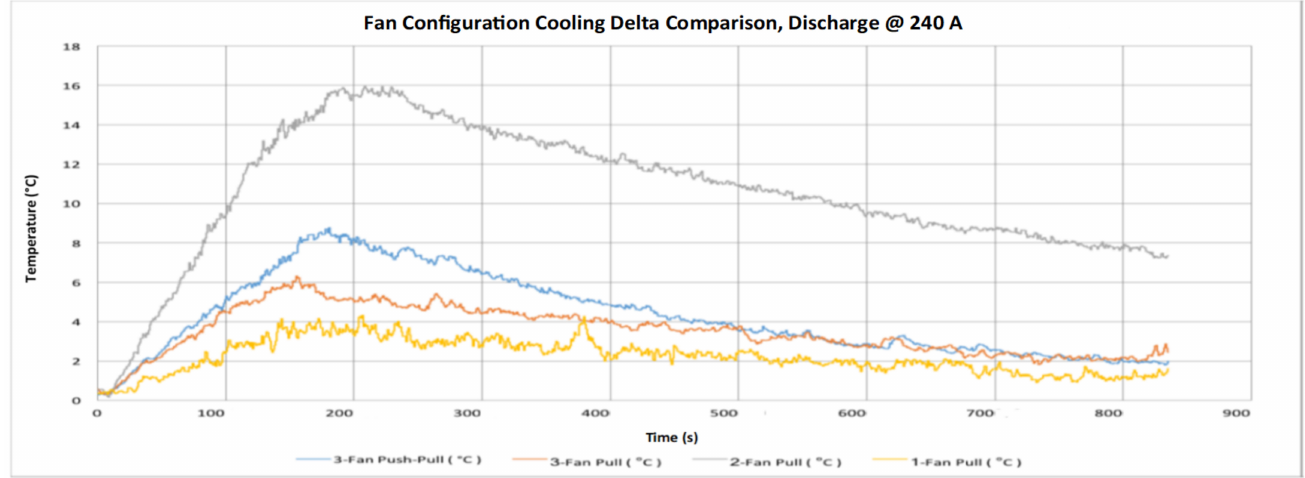
Figure 19. Module zero discharge, fan configuration cooling delta